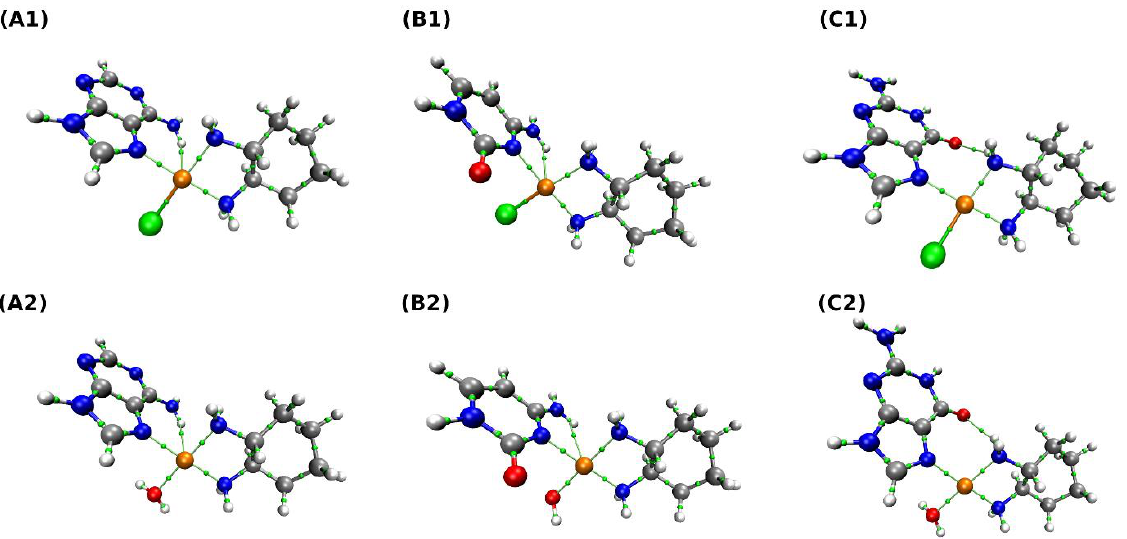
Figure 6. Atoms in molecules (AIM) molecular graphs of the studied complexes. The simulations were performed at the MN15/def2-TZVP level of theory. The BCPs of covalent and non-covalent interactions are presented and marked as small green spheres along bond paths. The designa- tions in Figure are as follows: ( A1 ) PtClDACH-Ade, ( A2 ) PtH 2 ODACH-Ade, ( B1 ) PtClDACH-Cyt, ( B2 ) PtH 2 ODACH-Cyt, ( C1 ) PtClDACH-Gua, ( C2 ) PtH 2